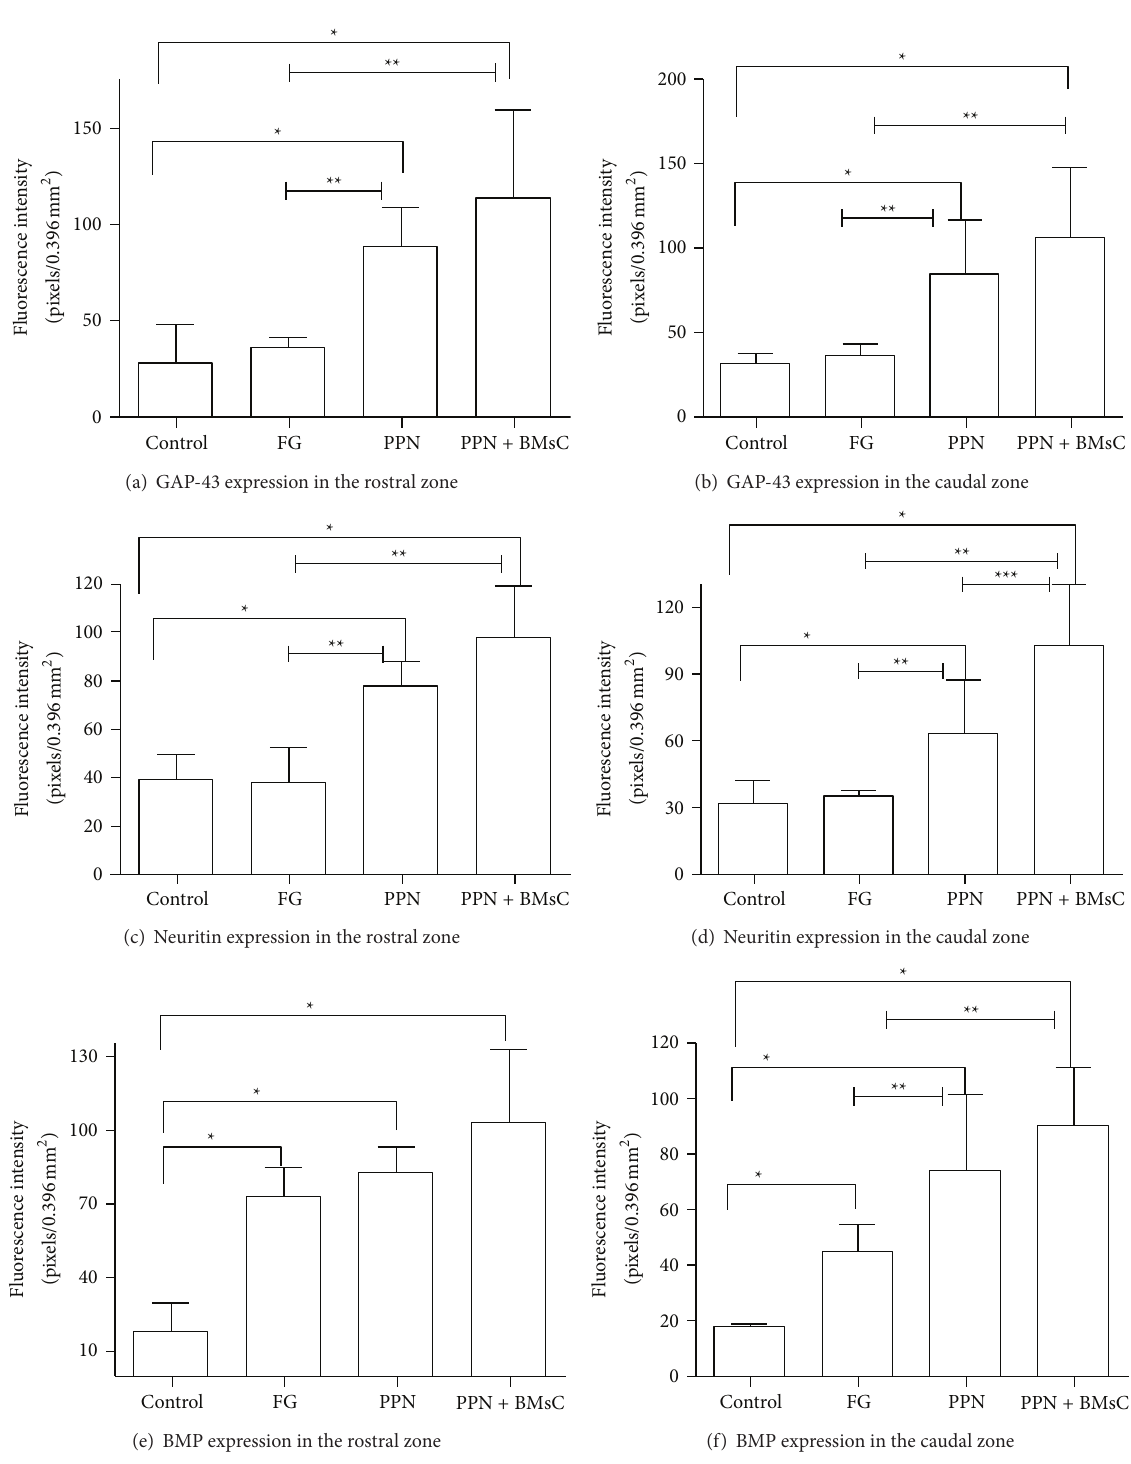
Figure 6: Fluorescence intensity analysis. Panels (a) and (b), expression of GAP-43: in both areas of the SC, a significant difference can be observed in the FG, PPN, and PPN + BMSCs groups compared to the Control group (Kruskal-Wallis test, 𝑝 < 0.05 ) as well as a significant difference in the treatment groups compared to the FG group (Mann-Whitney 𝑈 test, 𝑝 < 0.05 ). Panels (c) and (d), expression of Neuritin: it can be observed that the treatment groups obtained a significant difference when they are compared to the Control and FG groups (Kruskal- Wallis test and Mann-Whitney 𝑈 test, 𝑝 < 0.05 ). Panels (e) and (f), expression of PBM in the SC: in both areas, a significant difference is observed between the treated groups and the Control and FG groups (Kruskal-Wallis test and Mann-Whitney 𝑈 test, 𝑝 < 0.05 ); furthermore, in the distal zone, a significant difference can be observed between the PPN + BMSCs group compared with the PPN group (Mann-Whitney 𝑈 test, 𝑝 < 0.05 ). * is the difference with Kruskal-Wallis 𝑝 < 0.05 , and ** is the difference with 𝑈 -MANN 𝑝 < 0.05